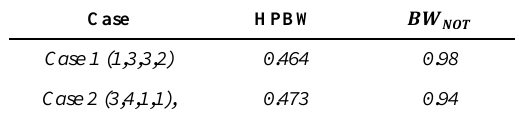
Table 8. Minimum redundancy arrays HPBW and 𝑩𝑾 𝑵𝑶𝑻 for 5-element